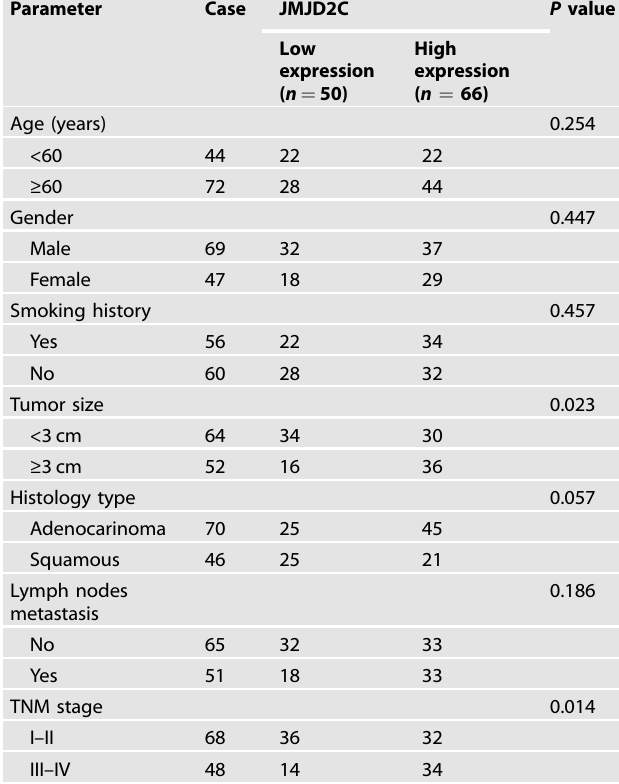
Table 1. The relationship between JMJD2C expression and clinicopathological characteristics in patients with